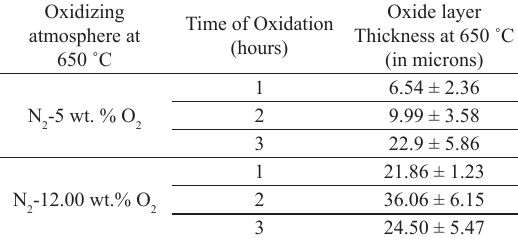
-5 wt.% O atmosphere and 2 2